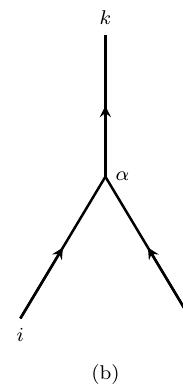
Figure 5 . (a) Graphical representation of the chosen basis. (b) Graphical representation of the dual basis.